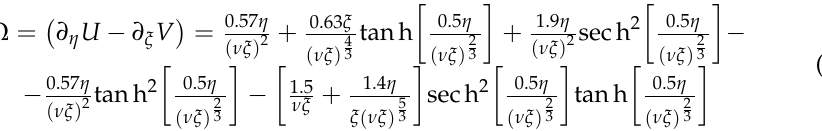
( d ) Figure 1. Dimensionless velocity field U of non-differentiable atmospheric multifractal: ( a ) ν = 0.5 , ( b ) ν = 1 , ( c ) ν = 1.5 , ( d ) ν = 2 .